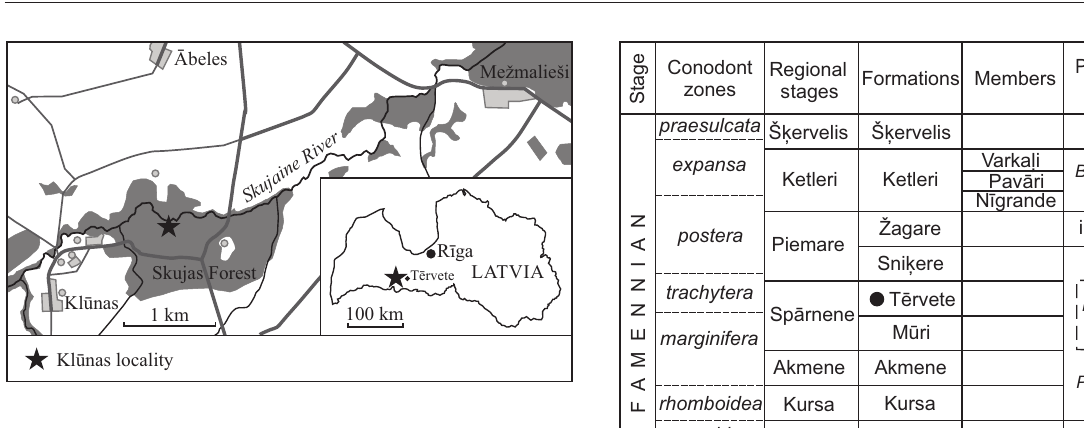
Fig. 1. Map of the vicinity of Tērvete showing the location of the Klūnas fossil site.